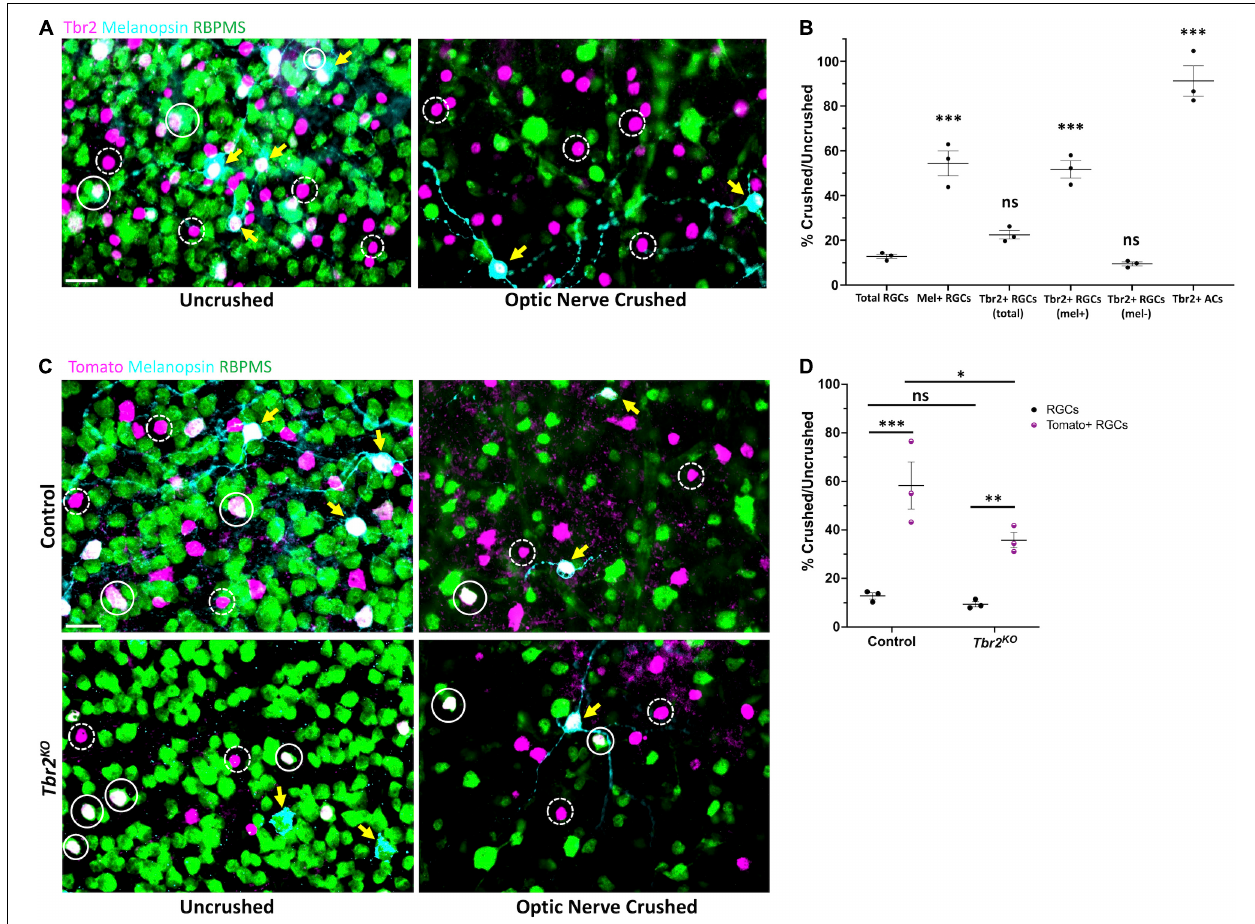
FIGURE 4 | Tbr2-expressing RGCs preferentially survive optic nerve injury and Tbr2 influences their survival. (A) Flatmounted retinas of a wildtype mouse 2 weeks after optic nerve crush in one eye (right, “optic nerve crushed”). The optic nerve of the contralateral control eye was not crushed (left, “uncrushed”). Both retinas were stained to reveal expression of Tbr2 (magenta), melanopsin (cyan), and RBPMS (green); solid white circles represent Tbr2 + RGCs that do not express melanopsin, yellow arrows point to melanopsin + Tbr2 + RGCs, dashed white circles indicate Tbr2 + amacrine cells, scale bar = 25 µ m. (B) Quantification of percent survival of cell populations of interest in ONC eyes normalized to uncrushed control eyes ( n = 3 mice, each dot represents the percentage for one mouse-4 FOVs/retina; mean ± SEM displayed; one-way ANOVA with Dunnett’s multiple comparisons, comparing each group to RGCs; *** P < 0.001, ns = P > 0.05). A significantly greater percentage of melanopsin + Tbr2 + RGCs survive ONC compared to other RGCs. (C) Left, flatmounted retinas of uncrushed control ( Tbr2 CreER / + ;tdT, top) and Tbr2 KO ( Tbr2 CreER / flox , bottom) eyes. Right, flatmounted retinas of optic nerve crushed control (top) and Tbr2 KO (bottom) eyes immunostained to reveal expression of Tomato (magenta), melanopsin (cyan), and RBPMS (green). Scale bar = 25 µ m. (D) Quantification of percent survival of Tomato + RGCs (purple, pattern) and all other RGCs (black, solid) in ONC eyes normalized to uncrushed control eyes in control and Tbr2 KO mice ( n = 3 mice for each group, each dot represents the percentage for one mouse-4 FOVs/retina; mean ± SEM displayed; two-way ANOVA with Sidak’s multiple comparisons, *** P < 0.001, ** P < 0.01, * P < 0.05, ns P > 0.05). Tomato + RGCs have increased survival relative to other RGCs in both control and Tbr2 KO mice but show decreased survival in Tbr2 KO mice.